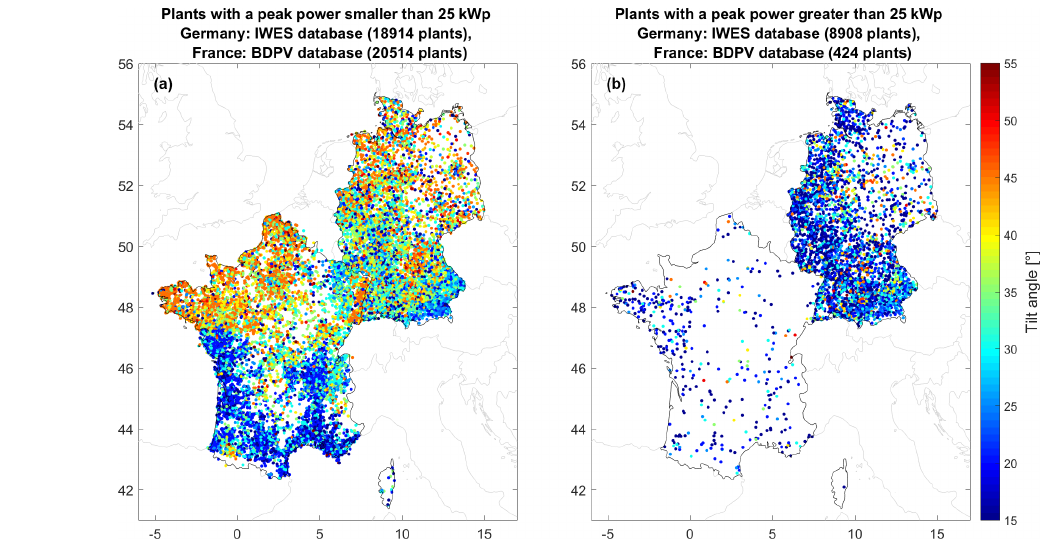
Figure 9. Spatial distribution of the tilt angle for plants smaller than 25kW p (a) and greater than 25kW p